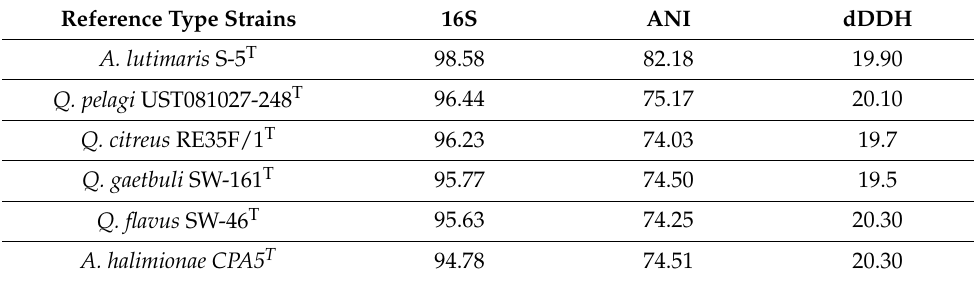
Figure 5. Tree inferred with FastME 2.1.6.1 [44] from GBDP distances calculated from genome sequences of strain NZ- 12B T . The branch lengths are scaled in terms of GBDP distance formula d5 . The numbers above branches are GBDP pseudo-bootstrap support values >60% from 100 replications. The tree was rooted at the midpoint. Table 3. ANI and dDDH values of NZ-12B T and its closely related phylogenetic